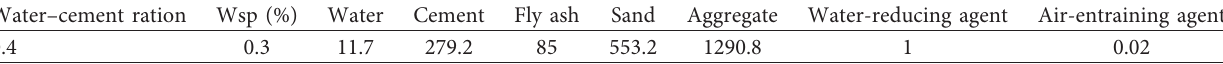
Table 1: Mix proportions concrete (kg/m 3 ).